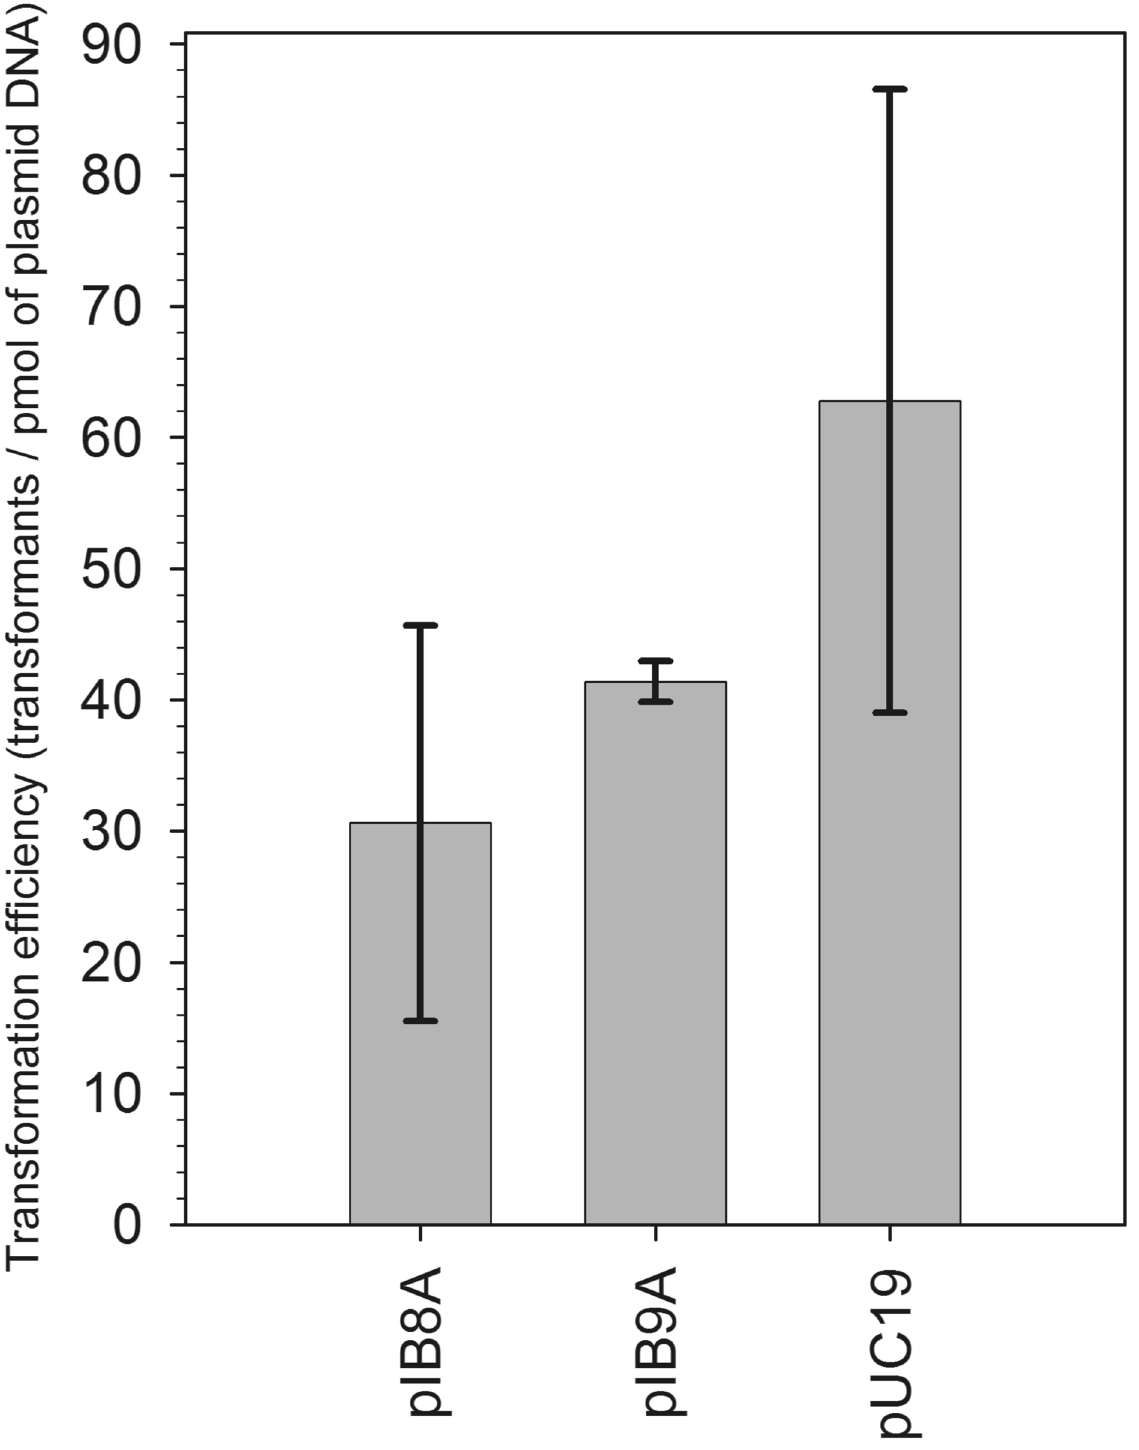
Fig 4. Efficiency of natural transformation of E . coli HB101 with pEC156-derivatives pIB8A (EcoVIII R + M + ) and pIB9A (EcoVIII R − M − ). Plasmid pUC19 was used as a control. Each column represents the mean value ( ± standard deviation) from three repeats. Statistical significance analyzed by Student ’ s t test revealed lack of correlation between presence of EcoVIII RM system and efficiency of natural transformation ( P = 0.12; Student t test).